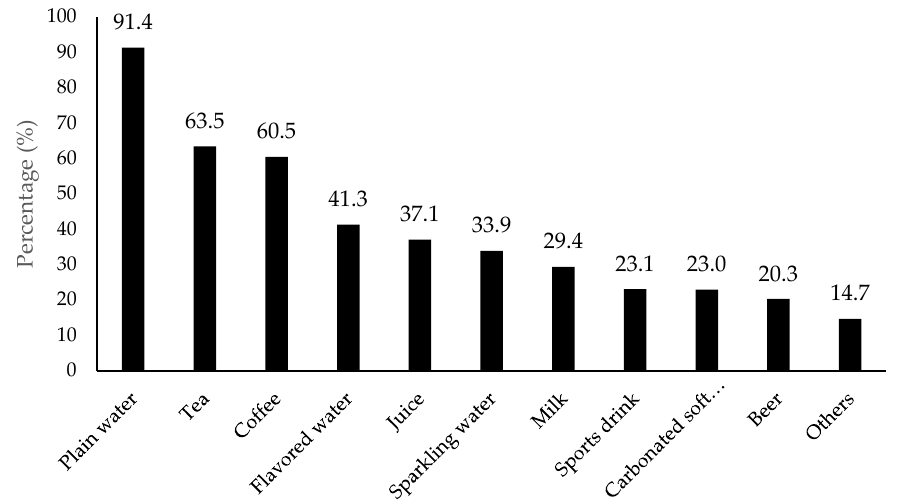
Figure 1. Percentage (%) for type of drinks/beverage that consumers drank the most ( n = 901). Others included soda, diet soda, wine, coconut water, kombucha, and non-dairy milk according to the collected data.